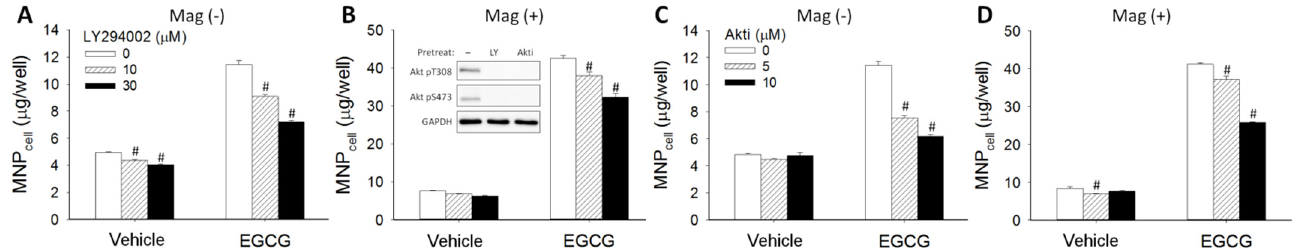
Figure 5. PI3K/Akt inhibitor attenuated EGCG-induced MNP uptake. After 30-min pretreatment with LY294002 (PI3K inhibitor; 10 or 30 µ M; ( A , B )) or Akti (Akt inhibitor; 5 or 10 µ M; ( C , D )), LN-229 cells were incubated with dextran-MNPs (50 µ g/well) with EGCG (10 µ M) in the absence ( A , C ) or presence ( B , D ) of the magnet for 6 h. Cells were pretreated with LY294002 (30 µ M) or Akti (10 µ M) for 30 min and treated with EGCG (25 µ M) for 1 h. Phosphorylation of Akt at Ser473 and Thr308 was measured by western blotting (B insert). Values are mean ± SEM ( n = 4); the results are representative of 4 experiments using different batches of cells. # p < 0.05 compared with the corresponding control group.